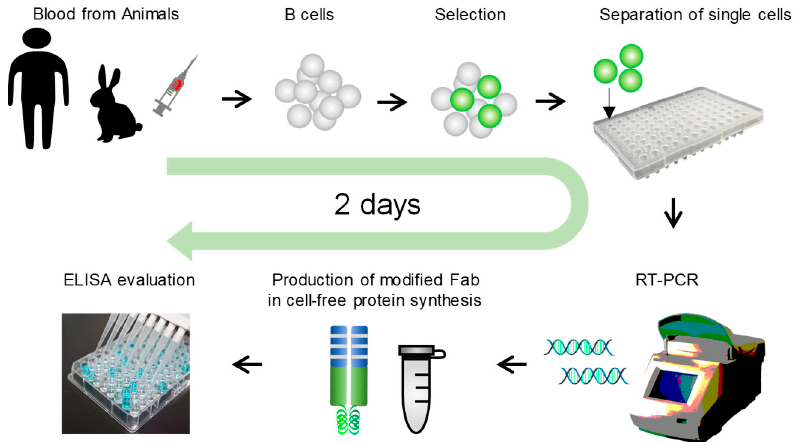
Figure 1. Scheme of the Ecobody technology. The whole process is seamlessly carried out in